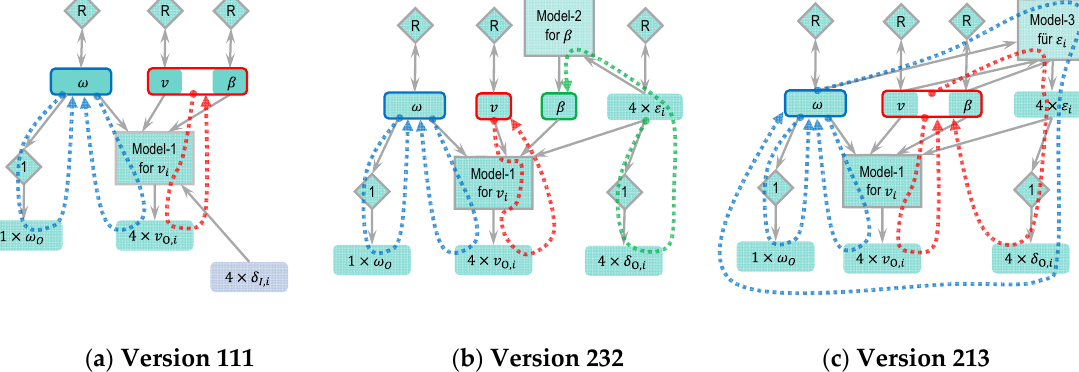
Figure 20. ( a ) Version 111: Correction paths for ω (blue), v and β (red). ( b ) Version 232: Correction paths for ω (blue), v (red) and β (green). ( c ) Version 213: Correction paths for ω (blue), v and β (red).